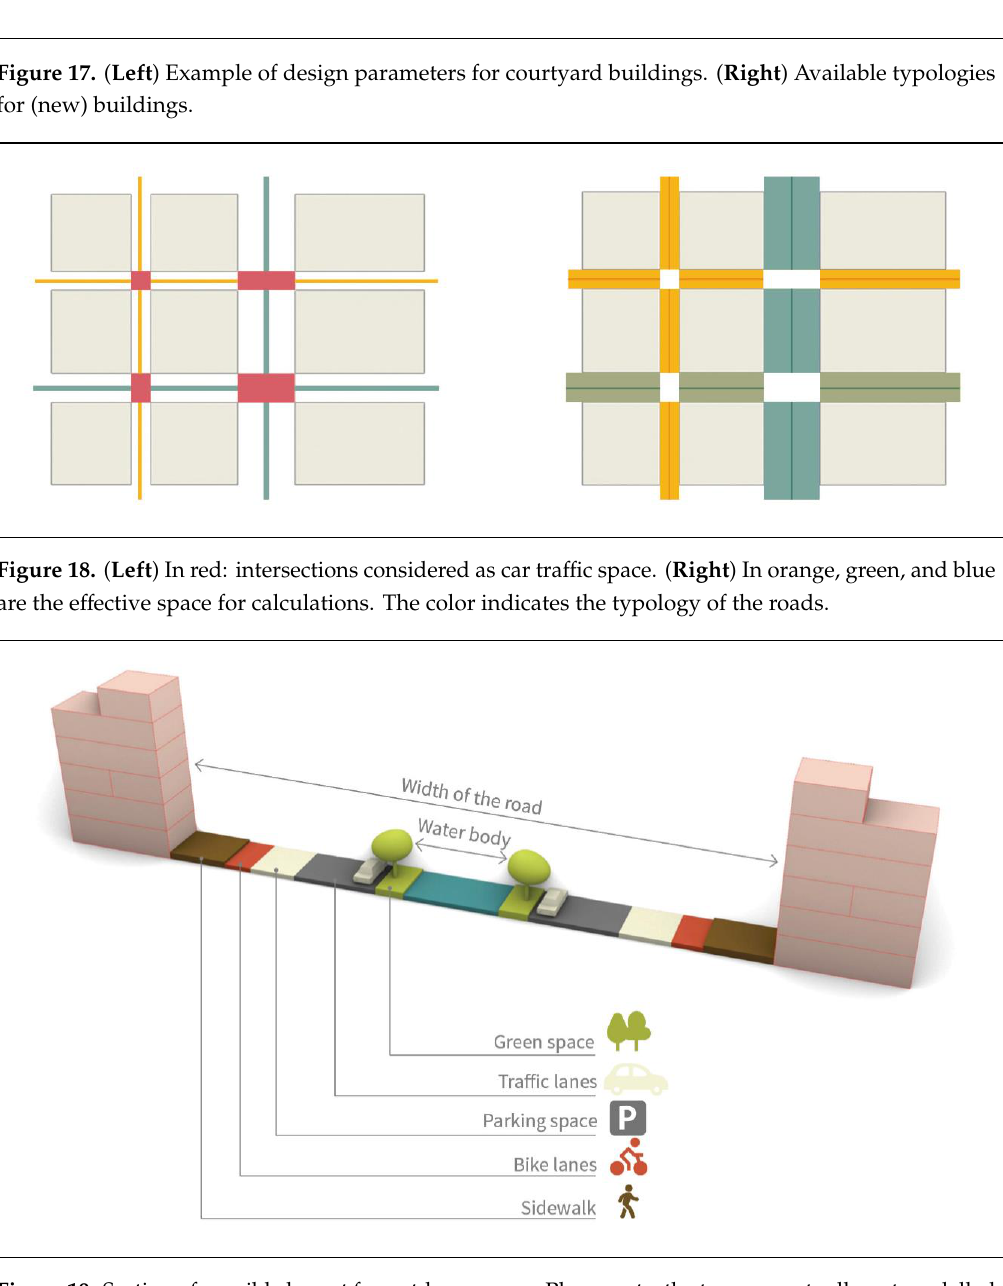
Figure 19. Section of possible layout for outdoor spaces. Please note, the trees are actually not modelled in Rhinoceros/Grasshopper. They are added here only for visualization purposes. Table 5. Excerpt of list of internal design parameters.